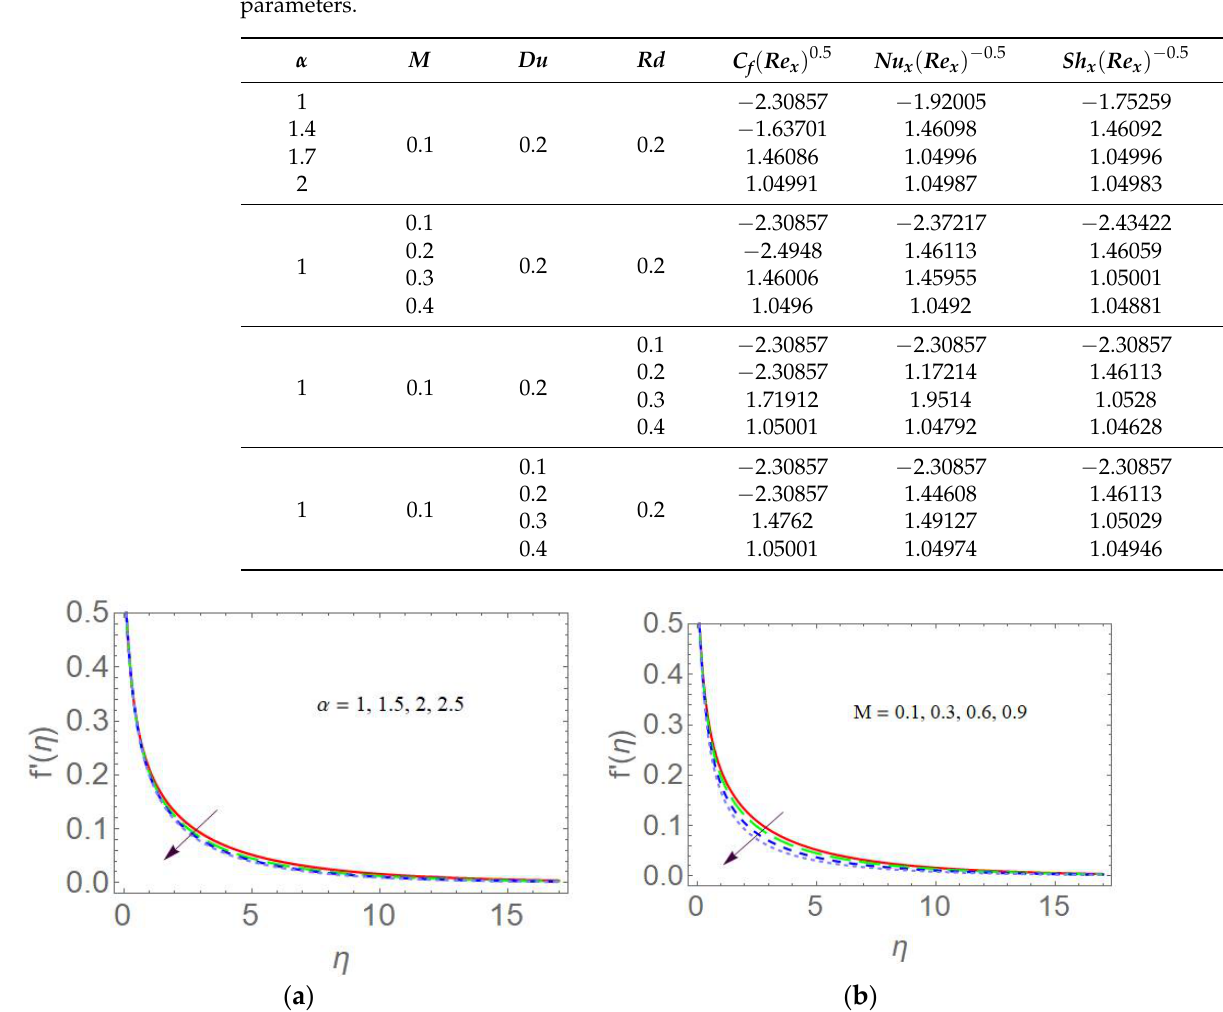
′ on and ( b ) Magnetic parameter M on ( 𝜂𝜂 ) 𝛼𝛼 𝑓𝑓